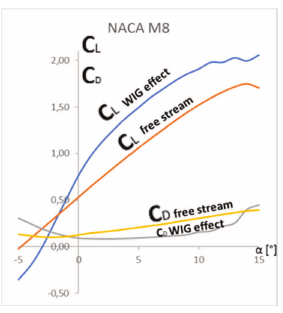
Fig. 2. Characteristics of NACA M8 profile